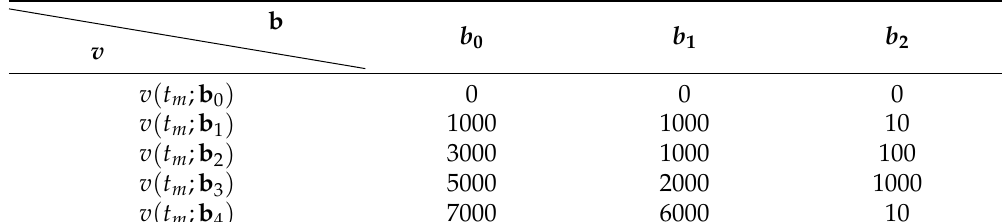
Table 2. Motion parameters for the simulation.